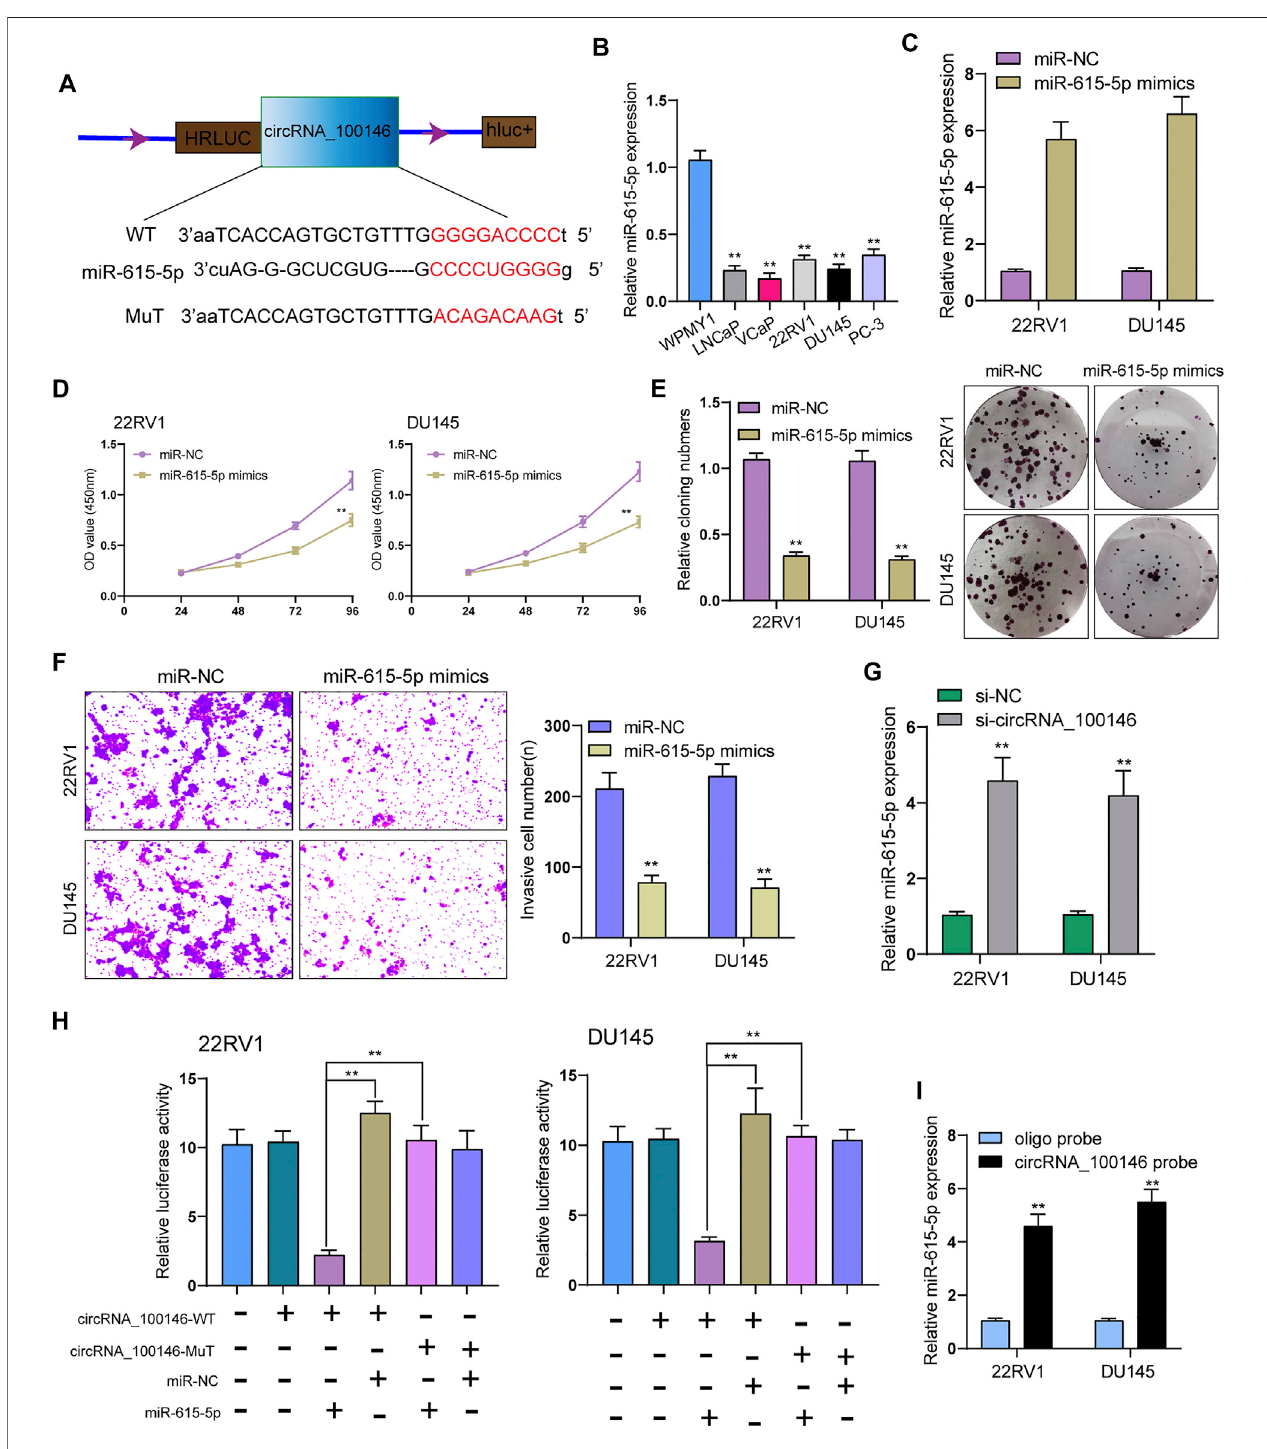
FIGURE 3 | CircRNA_100146 interacts with miR-615-5p in PCa cells. (A) Bioinformatical predication of interaction between circRNA_100146 and miR-615-5p. (B) The levels of miR-615-5p in four PCa cells and WPMY1 cells by RT-PCR. (C) RT-PCR determined the expression of miR-615-5p in 22RV1 and DU145 cells transfected with miR-NC or miR-615-5p mimics. (D) CCK-8 assays were used to measure PCa cell proliferation after transfection. miR-615-5p overexpression signi fi cantly suppressed 22RV1 and DU145 cell proliferation. (E) The cell viability and proliferative activity of 22RV1 and DU145 cells were assessed by colony formation assay following transfection with miR-NC or miR-615-5p mimics, respectively. (F) Transwell assays were performed to determine the invasive abilities of si- circRNA_100146 – transfected PCa cells. (G) miR-615-5p expression was decreased in 22RV1 and DU145 cells transfected with si-circRNA_100146 compared with those transfected withsi-NC. (H) Relative luciferaseactivity after co-transfectionofmiR-615-5p mimics,miR-NC, circRNA_100146-Mut, and circRNA_100146-WTinto 22RV1 and DU145 cells. (I) miR-615-5p was pulled down by circRNA_100146 in 22RV1 and DU145 cells. ** p < 0.01.